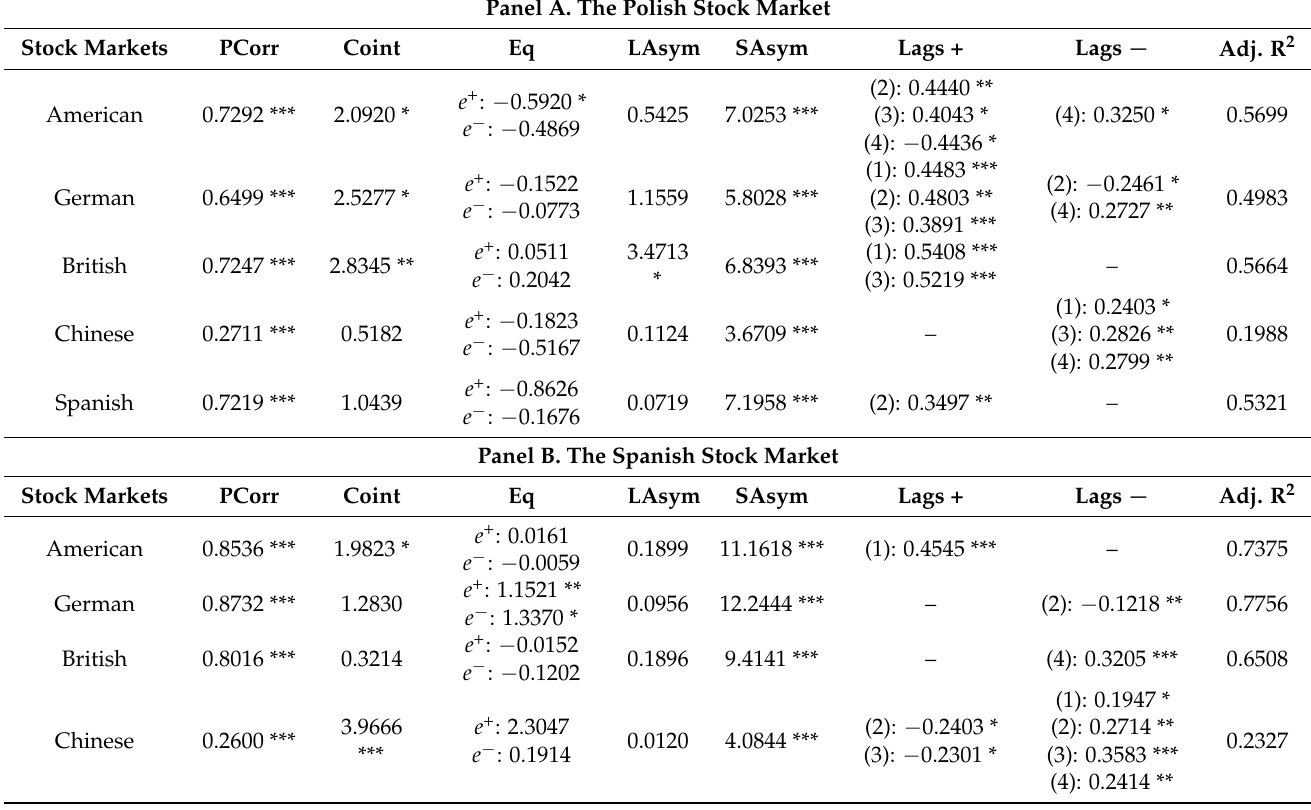
Table 6. Regression results of non-linear ARDL models: asymmetry and cointegration tests between the Polish (Panel A) and Spanish (Panel B) stock market and international (the American, German, British and Chinese) stock markets: